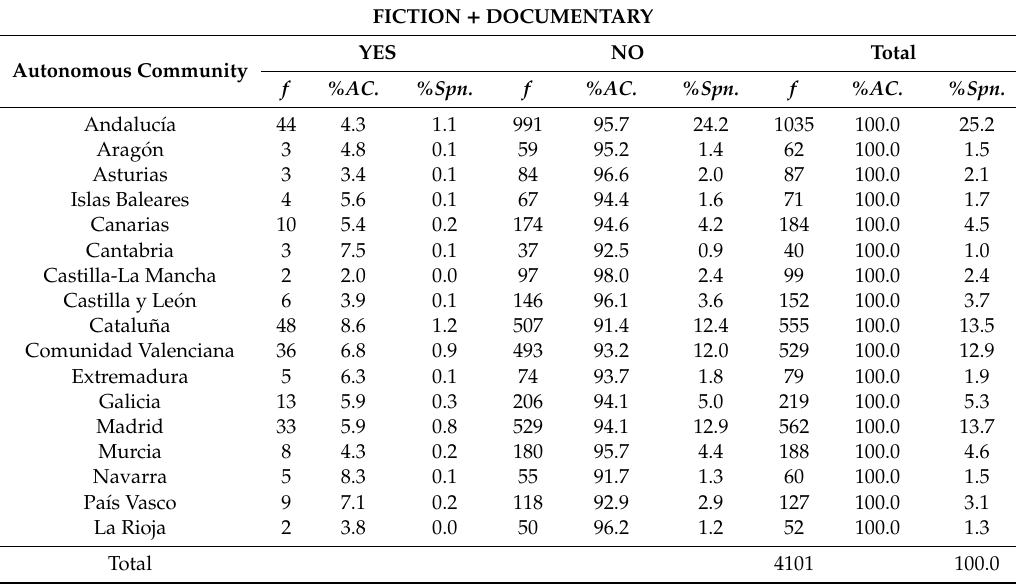
Table 7. Percentages and frequencies of fiction and documentary films seen by teacher (cid:48) s degree students, according to the Autonomous Community.